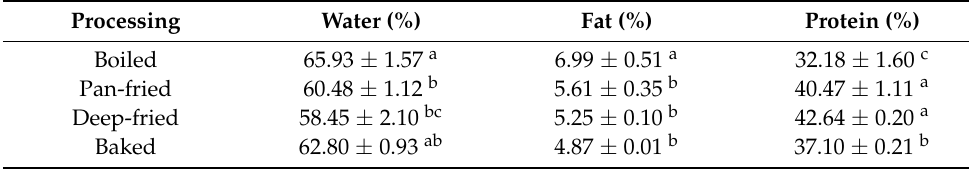
Table 3. Nutritional quality indicators of differently processed BTS meat.